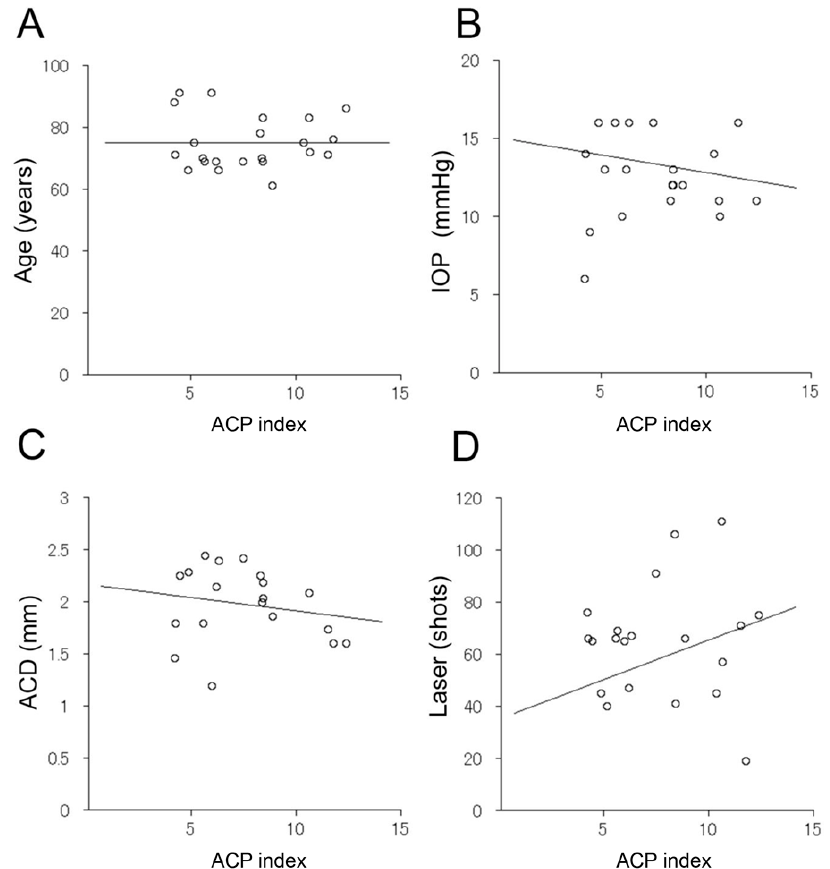
Figure 4. Correlations between ACP index and each factor. The correlations between ACP index immediately after LI and age, intraocular pressure, anterior chamber depth, and total number of lasers were determined. No significant correlations were observed ( A , ACP index vs. age, r = 0.081 ( p = 0.782); B , ACP index vs. IOP, r = − 0.198 ( p = 0.377); C , ACP index vs. ACD, r = − 0.184 ( p = 0.450); D , ACP index vs. total PC, r = 0.082 ( p = 0.717)).